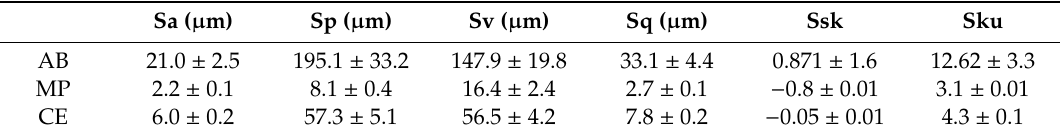
Figure 2. Surface morphology of ( a , d ) as-built; ( b , e ) mechanical-polished; ( c , f ) chemical-etched samples.